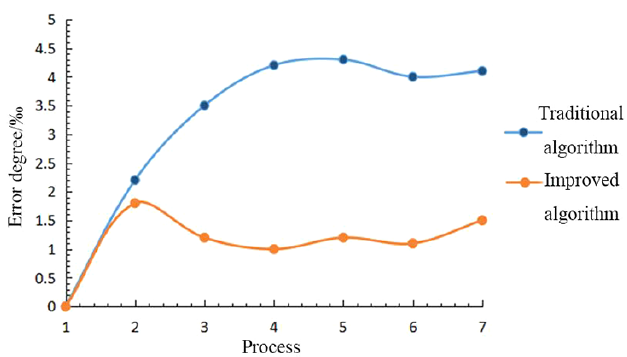
Fig. 4. Comparison of errors in the operation process of the two